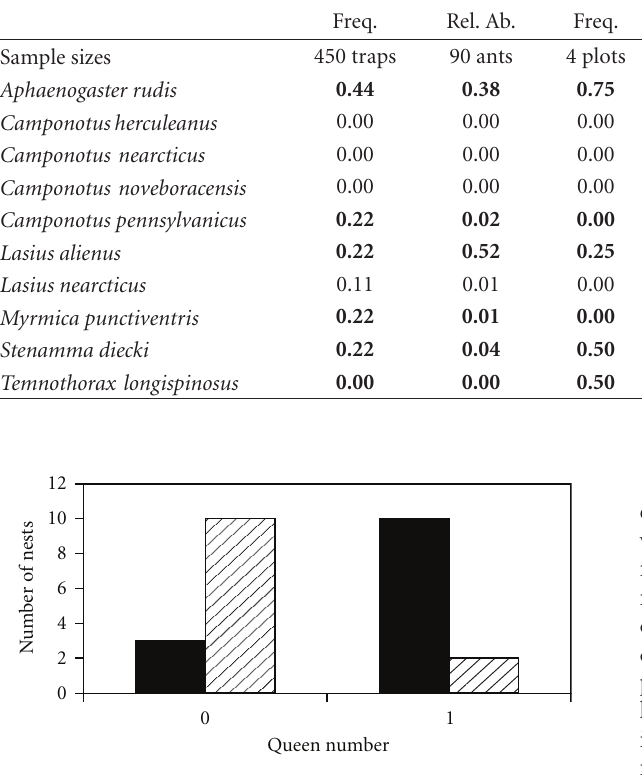
Figure 3: Queen number in Aphaenogaster rudis nests. Nests were collected in edge (solid bars) and interior habitat litter plots (diagonal hatched bars). Sample sizes were n = 13 edge nests and n = 12 interior